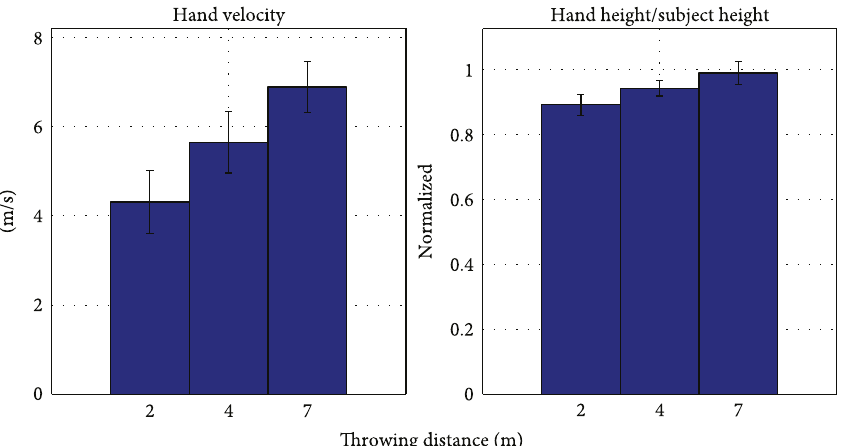
Figure 8: Representative task space representation for all subjects f shown in Figure 5. The global increase of both features with regard to the throwing distance is straightforward.